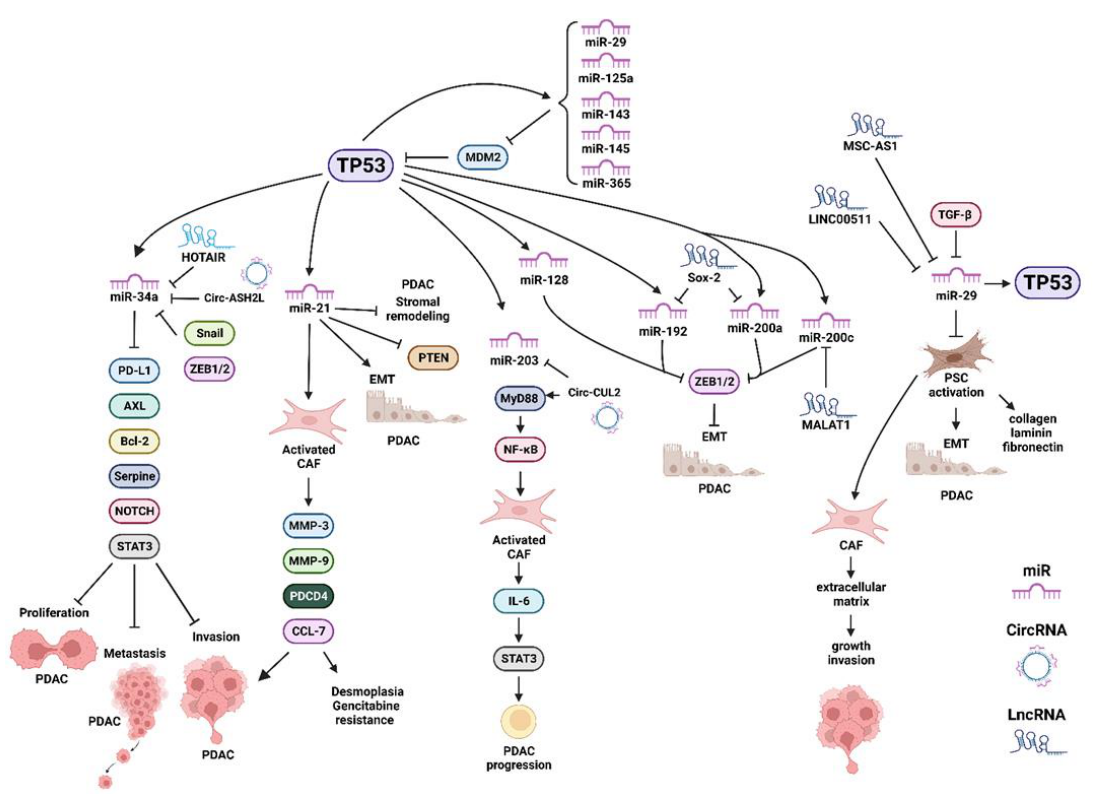
Figure 3. Various miRs, LncRNA and circRNAs Induced by TP53 which have Effects on: Proliferation, EMT, Migration, Invasion, Metastasis, Desmoplasia and Drug Resistance. Programed cell death ligand 1 (PD-L1), B-cell lymphoma-2 gene (Bcl2), AXL = AXL receptor tyrosine kinase, plasminogen activator inhibitor-1 (serpine-1), signal transducer and activator of transcription 3 (STAT3), matrix metallopeptidase 3 (MMP3), matrix metallopeptidase 9 (MMP9), programmed cell death 4 (PDCD4), chemokine ligand 7 (CCL7), MyD88 = myeloid differentiation primary response protein MyD88 (MyD88), IL-6 = interleukin 6 (IL-6), Zinc finger E-box-binding homeobox 1/Zinc finger E-box-binding homeobox 2